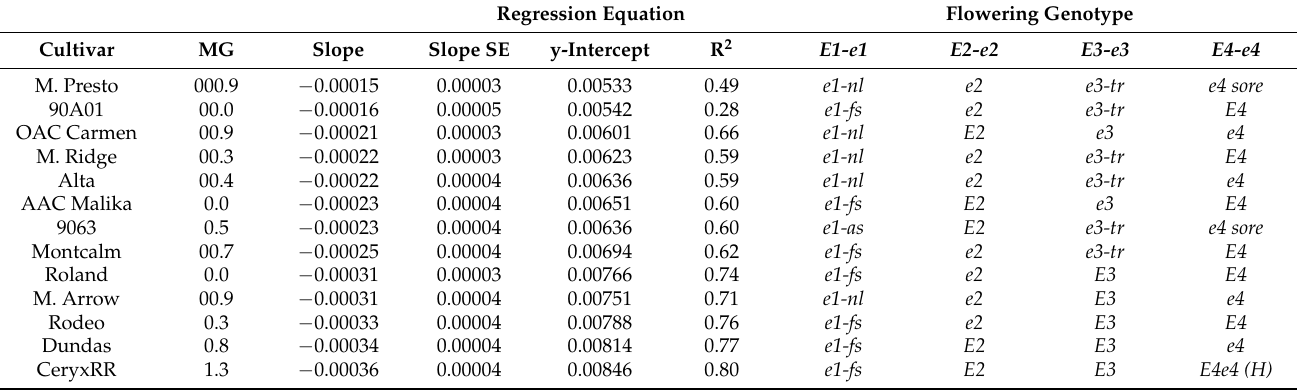
Table 3. Cultivar, maturity group (MG), slope (development h − 1 d − 1 ), standard error (SE) of the slope, y -axis intercept, and coefficient of determination (R 2 ) for the plant development rate regressed with photoperiod treatments of 14, 15, 16, and 17 h from emergence (VE) to beginning bloom (R1). Regression